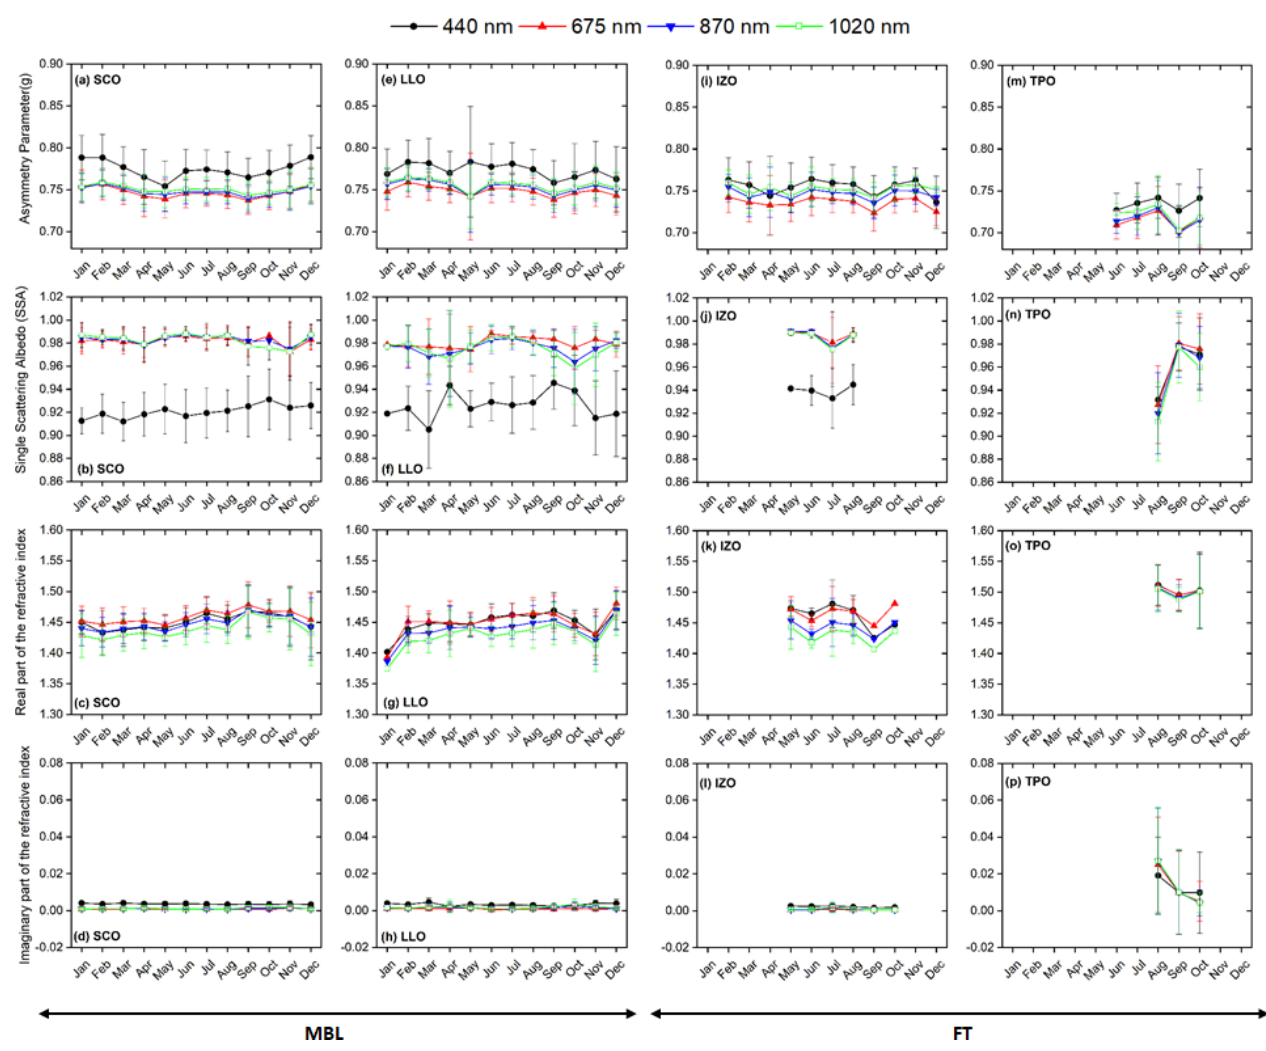
Figure 9. Monthly mean asymmetry parameter ( g ), single scattering albedo (SSA), and real ( n ) and imaginary ( k ) parts of the refractive index at 440 (black), 675 (red), 870 (blue) and 1020nm (green) at SCO (a–d) , LLO (e–h) , IZO (i–l) and TPO (m–p) under dust-laden conditions. Error bars indicates the standard